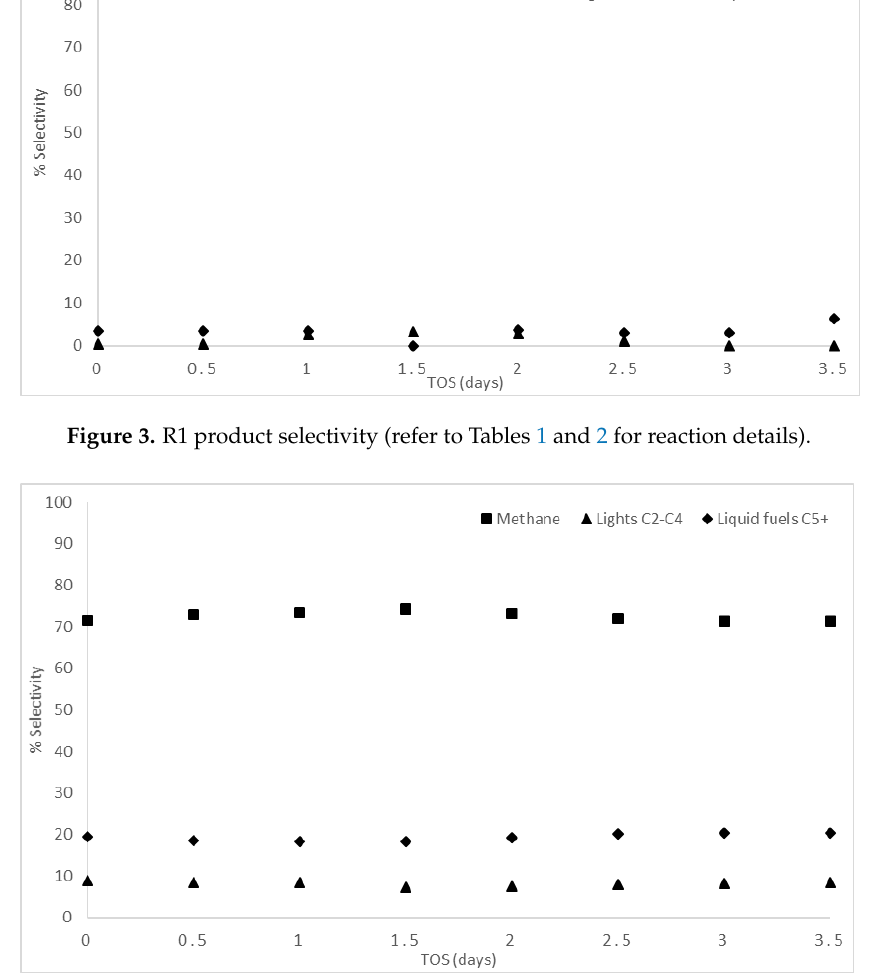
Figure 4. R2 product selectivity (refer to Tables 1 and 2 for reaction details).